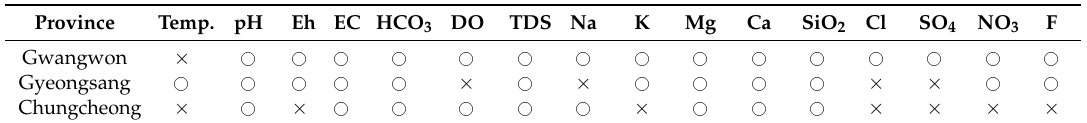
Table 13. Major parameters for identification for the three areas with distinct indicator ( indicator ( × ).